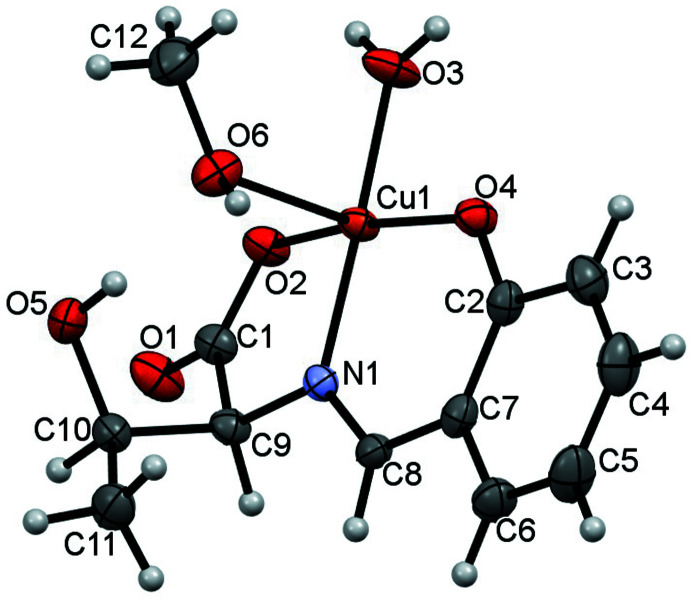
The mol­ecular structure of the title compound, showing the atom-labelling scheme. Displacement ellipsoids are drawn at the 30% probability level.